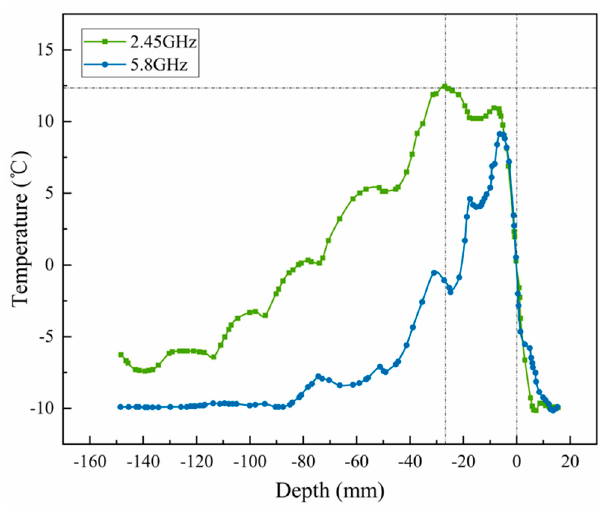
Figure 7. Temperature field distribution along the vertical direction of concrete.